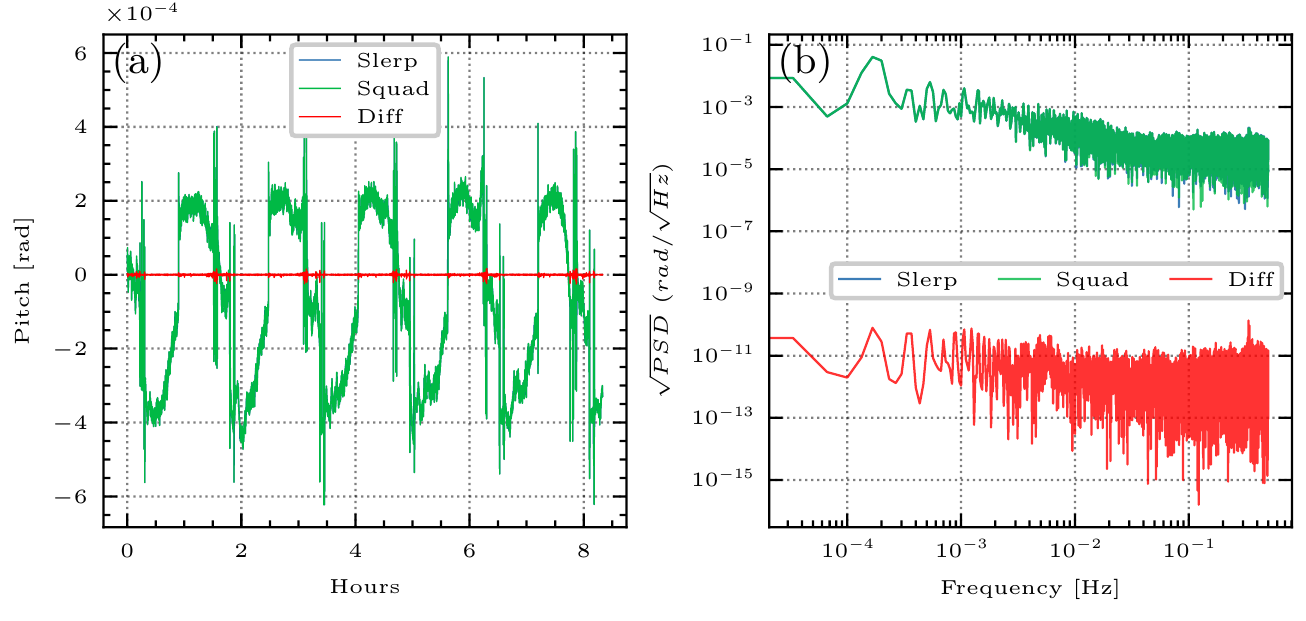
Figure 4. Comparisons of the inter-satellite pointing variation (in terms of the pitch, see Section 3.4) derived from Slerp and Squad interpolation methods, respectively. Results of time-series and spectra (power spectral density) are shown in the left ( a ) and right ( b ),